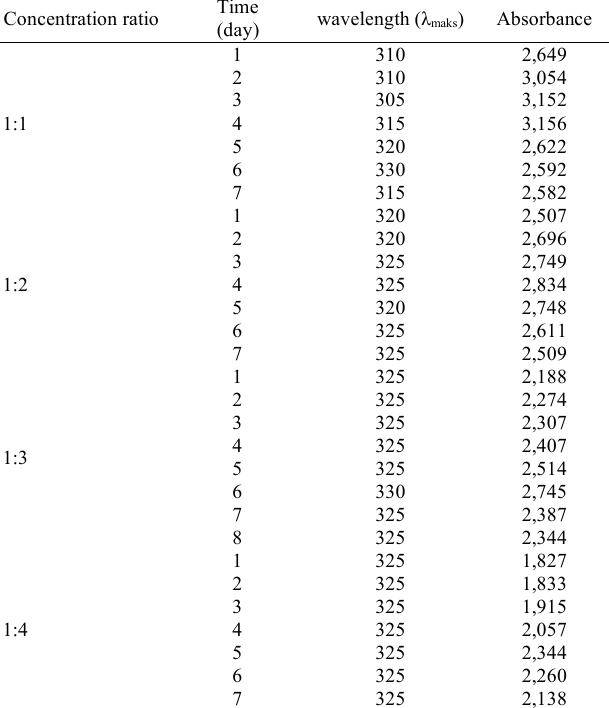
Table 2. Determination of optimum